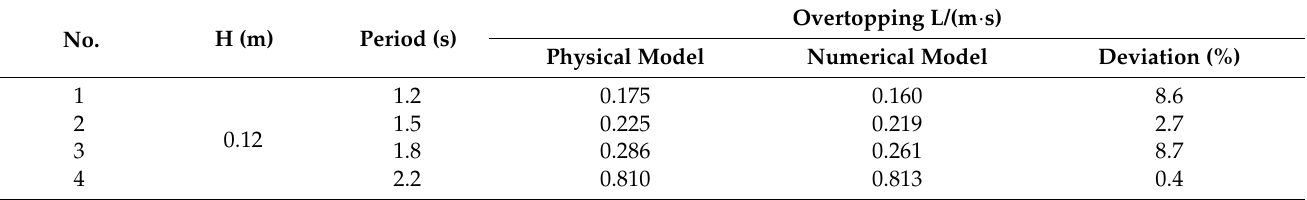
Table 4. Comparison of wave overtopping between the numerical model and physical model.